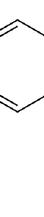
Figure 10. The diazido-complex described in [42].